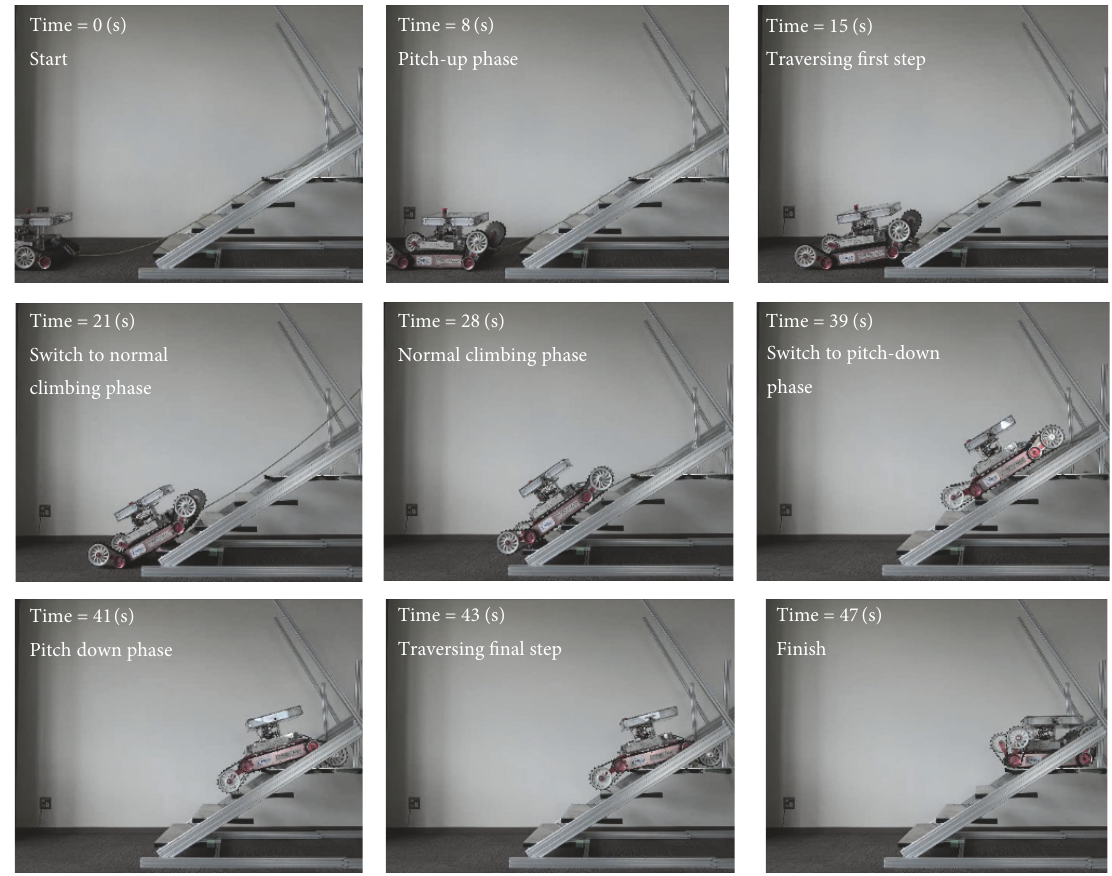
Figure 19: Climbing-up behavior for case 𝜃 𝑠 = 30 ∘ , 𝑝 = 300